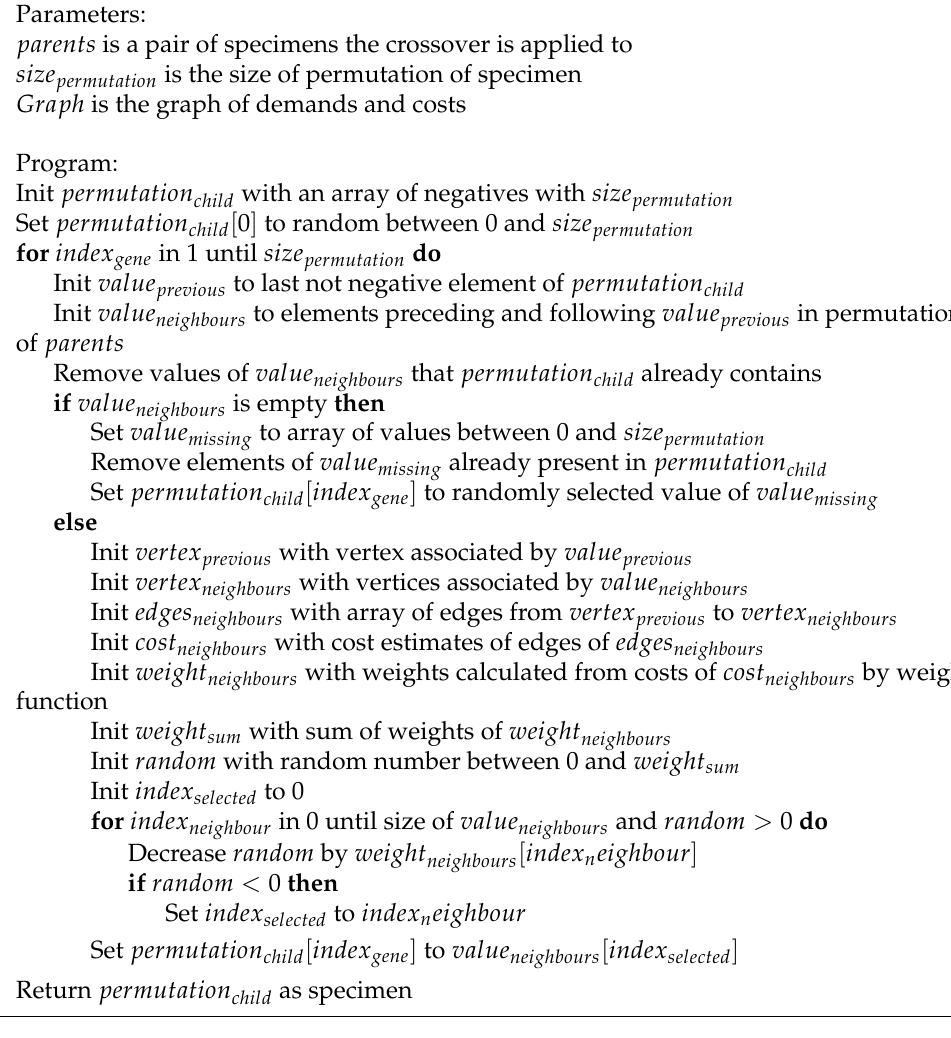
Algorithm 4 Heuristic crossover with one child produced